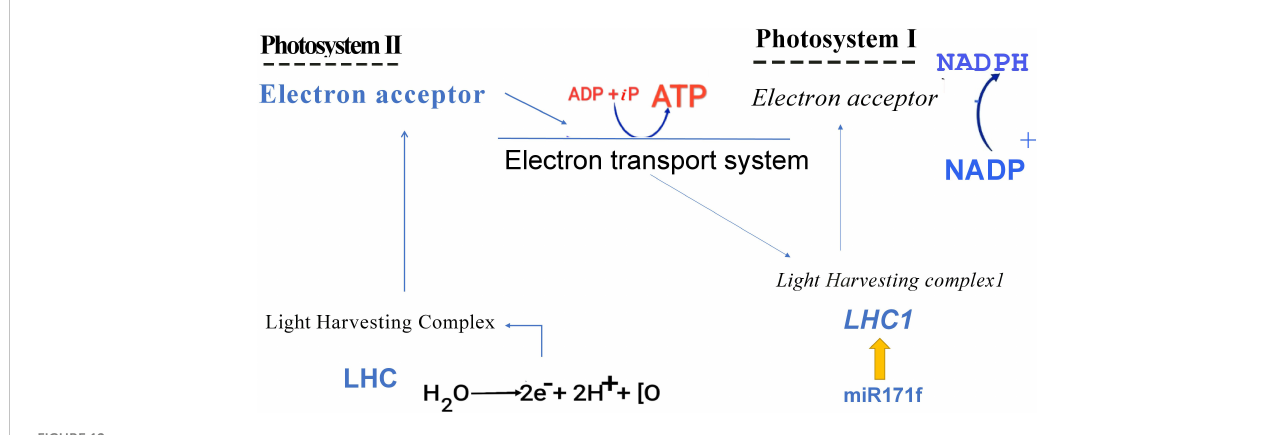
FIGURE 12 Graphical representation of proposed